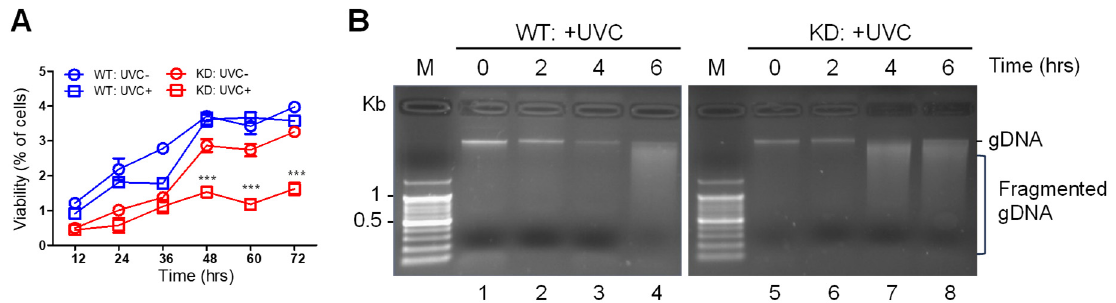
Figure 6. SMUG1 ablation reduced cell viability and induced gDNA fragmentation after UVC irradiation. ( A ) Cell viability of HepG2 WT and SMUG1 KD cells irradiated to UVC of 125 mJ/cm 2 and analyzed by MTT assay. ( B ) Fragmented gDNA was visualized by the agarose gel running after UVC irradiation in SMUG1 WT and KD HepG2 cells. Error bars show mean ± SEM. p values obtained by two-way ANOVA. *** p value < 0.001, ** p value < 0.01; n.s, not significant.